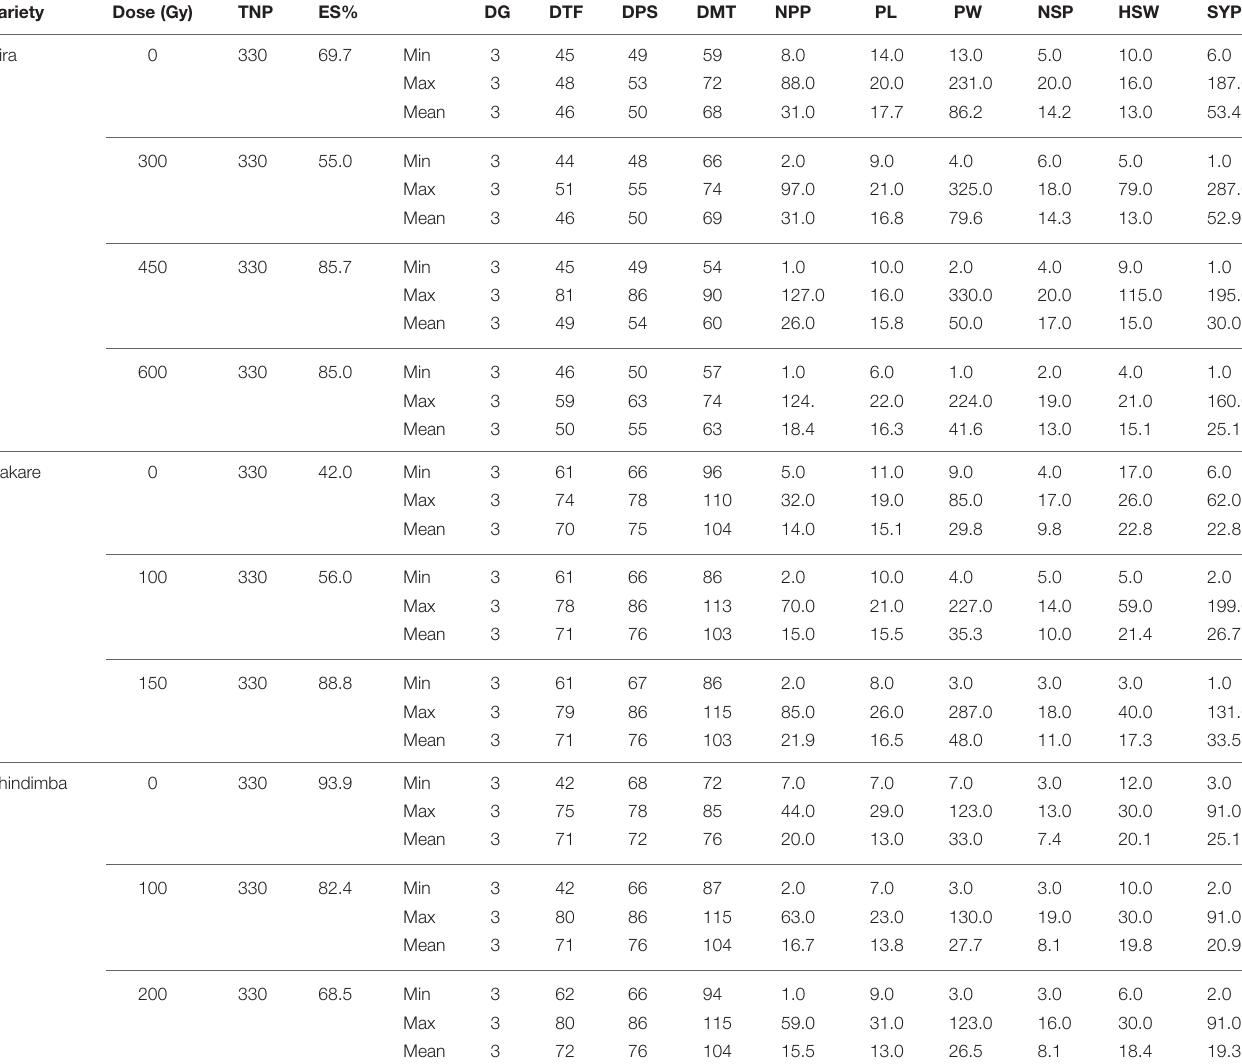
TABLE 5 | Quantitative characteristics of M 4 cowpea mutant lines irradiated at different gamma radiation doses (Gy) in relation to their parental lines/control (Gy 0) observed at Omahenene Research Station during 2012/2013 season. Variety Dose